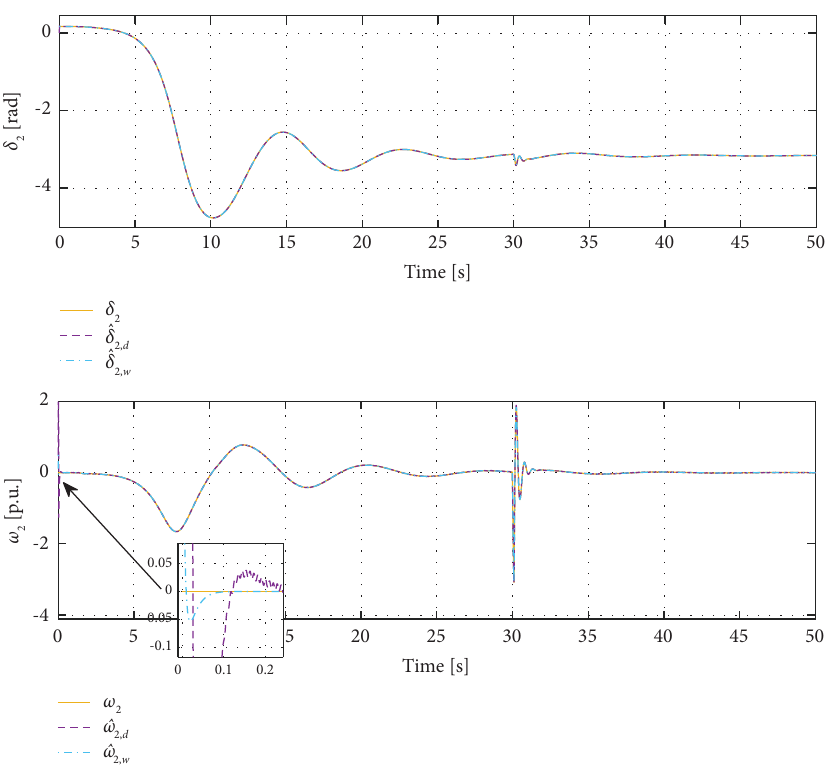
Figure 4: Comparison between the L-D GE estimators: load angle and relative speed of generator two.